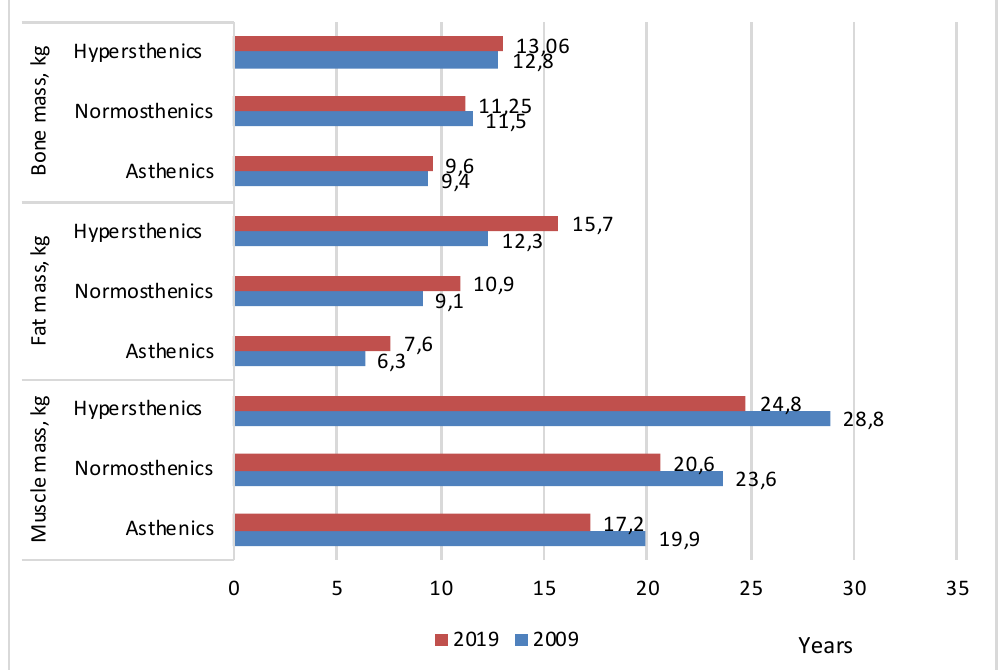
Fig.2. The content of bone, fat, and muscle components of the body mass in females with different somatotypes in 2009 and Table 3. Indicators of motor qualities of females (%)